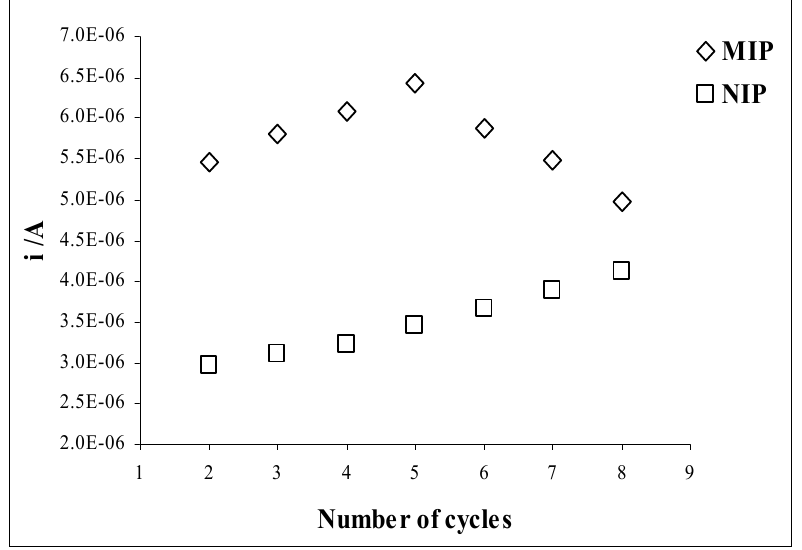
Figure 9. Effect of the number cycle to ( ∆ ) MIP and ( □ ) NIP electrodes for 0.10 mM sulfamethoxazole in 50% (v/v) acetonitrile-water Britton-Robinson buffer at pH